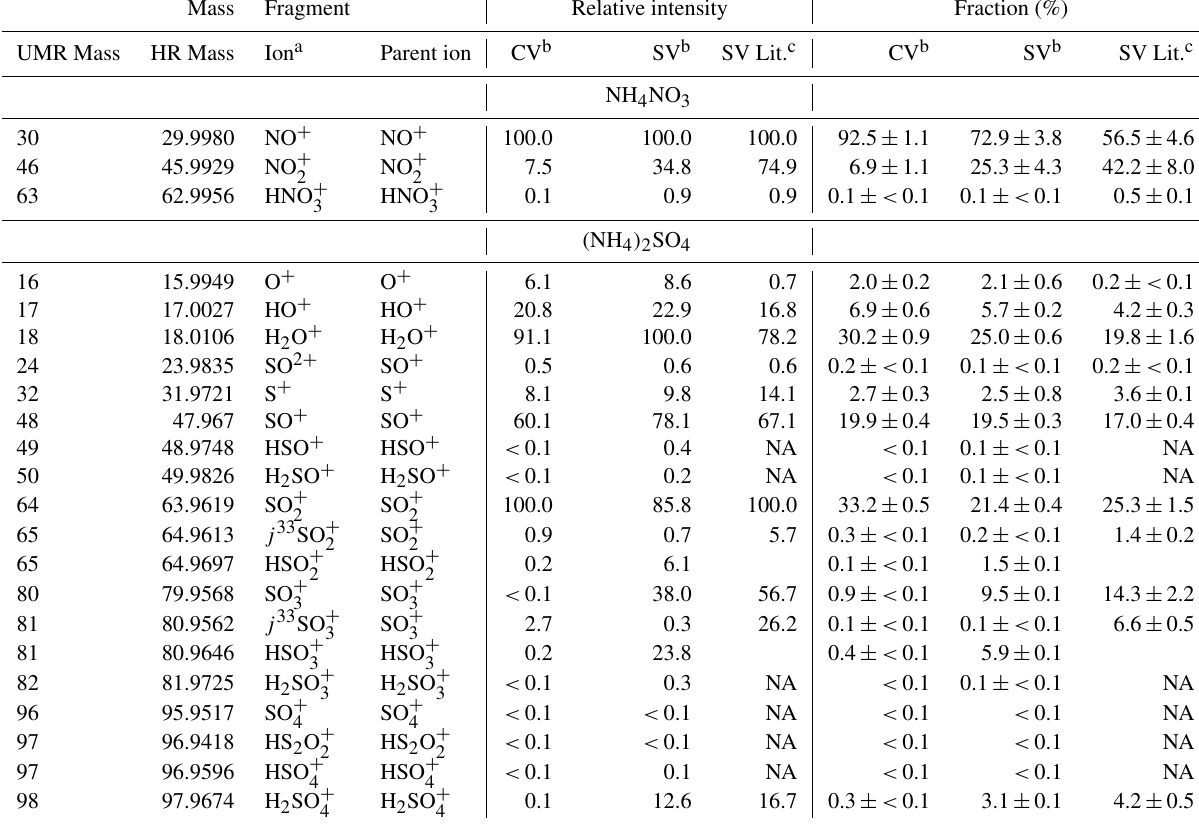
Table 1. Fragmentation patterns of particulate nitrate from NH 4 NO 3 particles and particulate sulfate from (NH 4 ) 2 SO 4 particles. Both fragmentation patterns were measured in pure argon gas. The intensity relative to the largest peak and the fraction of total are reported. The uncertainties of the fragment fractions correspond to the variability of the data as 1 standard